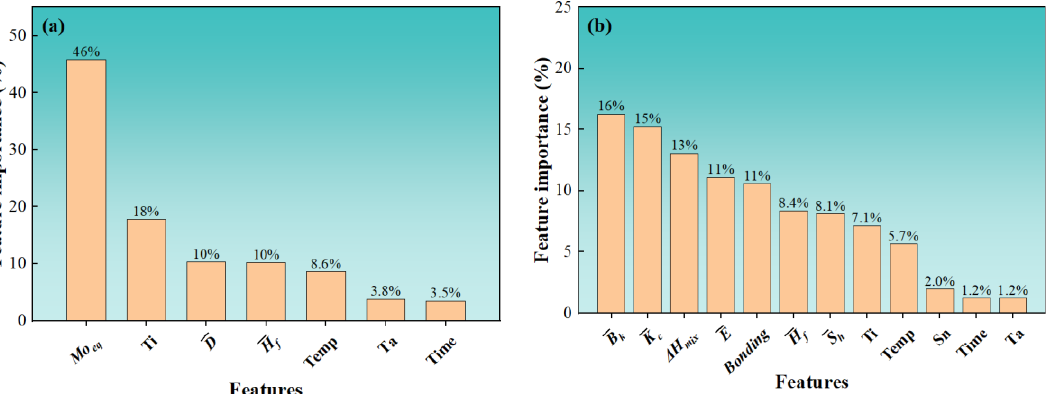
Figure 6. Feature importance analysis, which is used to observe the percentage of importance of features of the predicted target: ( a ) classification model and ( b ) regression model.